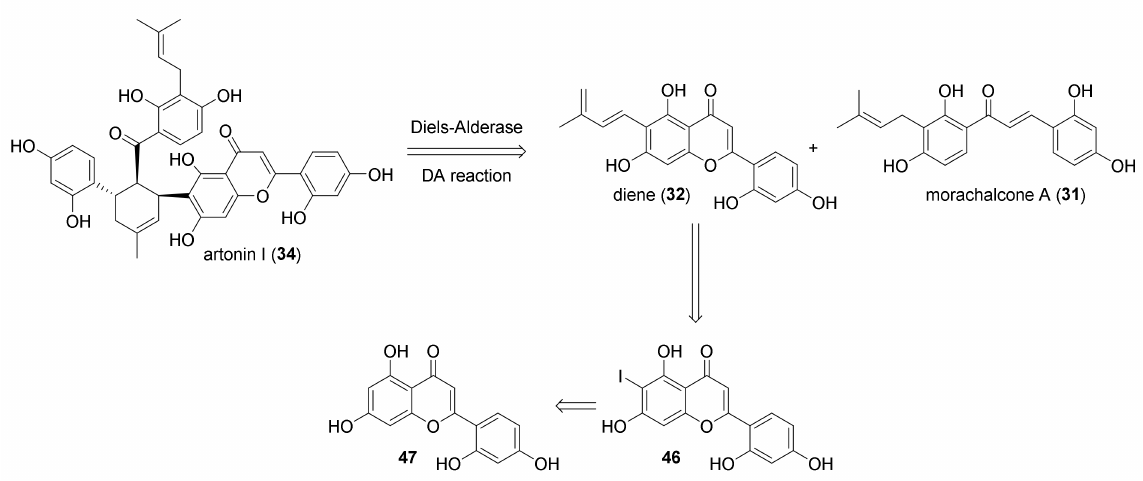
Figure 14. Substrate scope of MaDA and chemoenzymatic synthesis of natural DAAs.